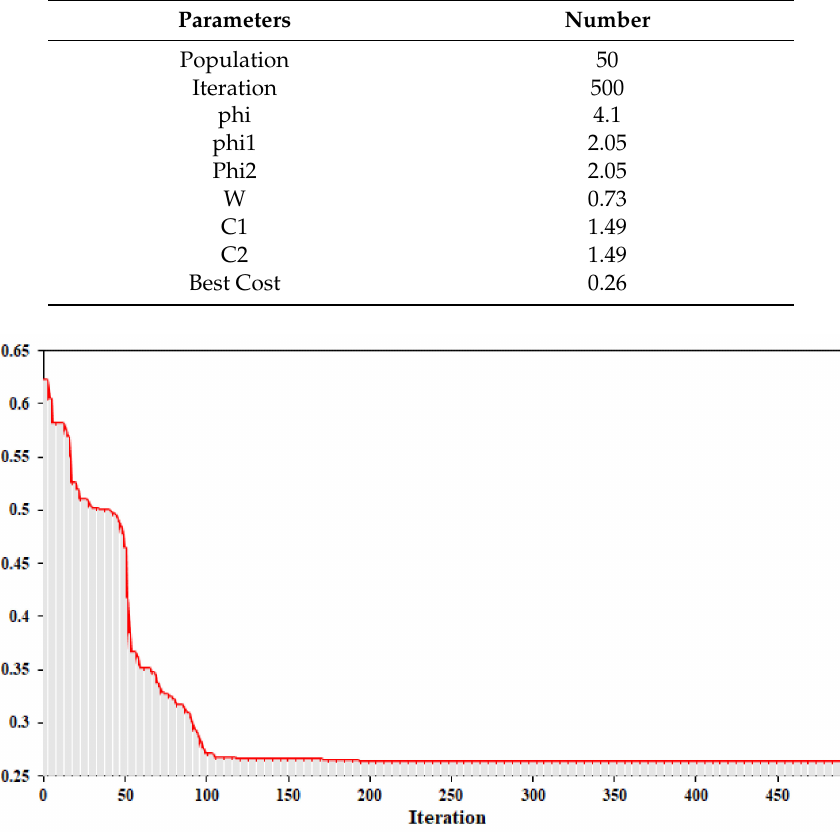
Figure 10. Convergence graph of the objective cost function (MSE) in the PSO-DLNN